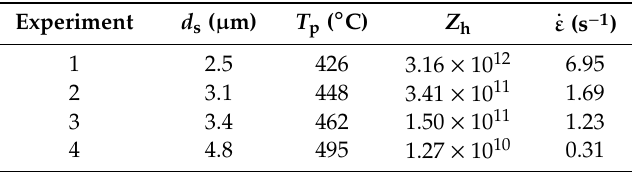
Figure 3. Schematic diagram showing the region A where optical micro-graphs are analyzed and local strain rate is computed. Table 5. Estimated local strain rates and sub-grain diameter. Table 5. Estimated local strain rates and sub-grain diameter.